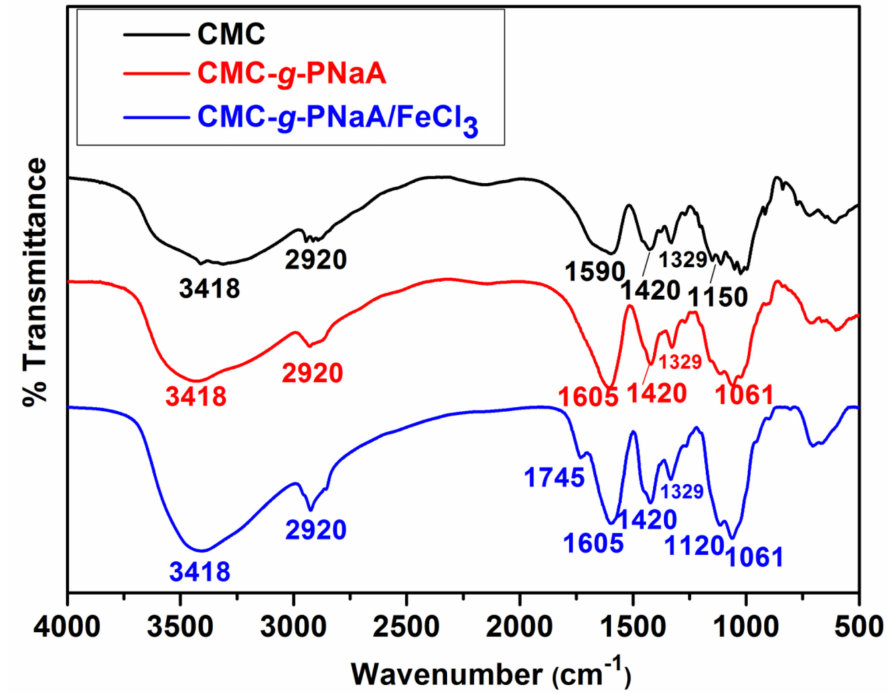
Figure 1. Fourier transform infrared spectroscopy (FTIR) of CMC, CMC- g -PNaA and CMC- g -PNaA / FeCl 3